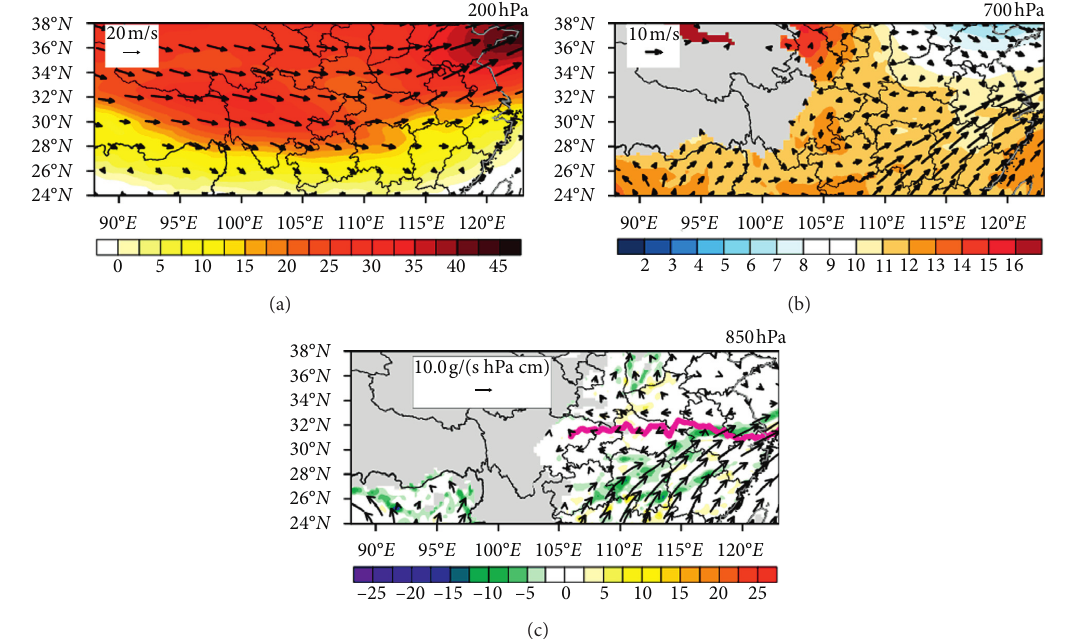
Figure 1: Time-mean (a) wind vectors (units: m/s) and zonal wind velocity (shaded; units: m/s) at 200hPa, (b) wind vectors (units: m/s) and air temperature (units: ° C) at 700hPa, and (c) moisture flux (units: gs − 1 hPa − 1 cm − 1 ), moisture flux divergence (shaded; units: 10 − 7 g s − 1 hPa − 1 cm − 2 ), and the time-mean location of the Meiyu front at 850hPa (solid purple